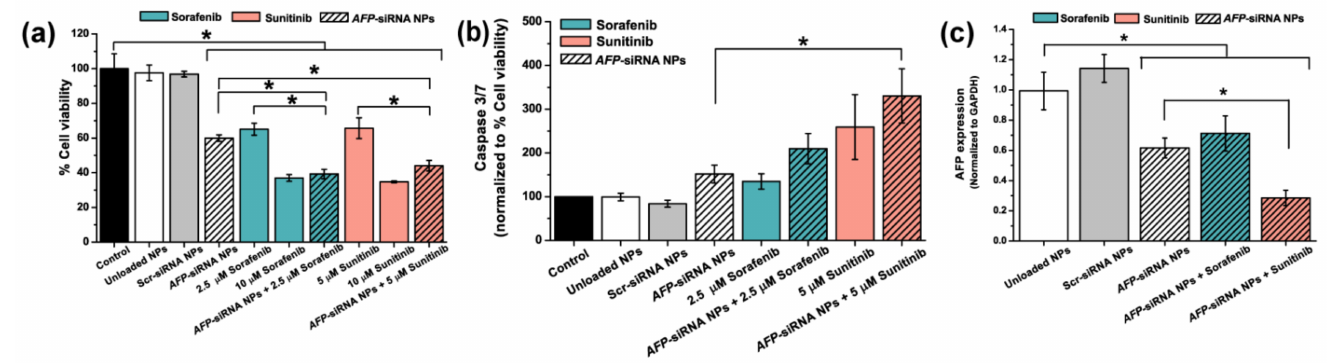
Figure 4. Antiproliferation and gene silencing effects of sorafenib or sunitinib in combination with AFP -siRNA loaded NPs on HepG2 cell line. ( a ) Percentage of cell viability of the cells. ( b ) Caspase 3/7 activity of the cells when treated with either single or combined treatments of AFP -siRNA NP and drugs. ( c ) Gene silencing effect of combined treatments of siRNA and drugs compared to the single use of AFP -siRNA NPs alone. Significance was set at p -values of p < 0.05 and indicated with an asterisk